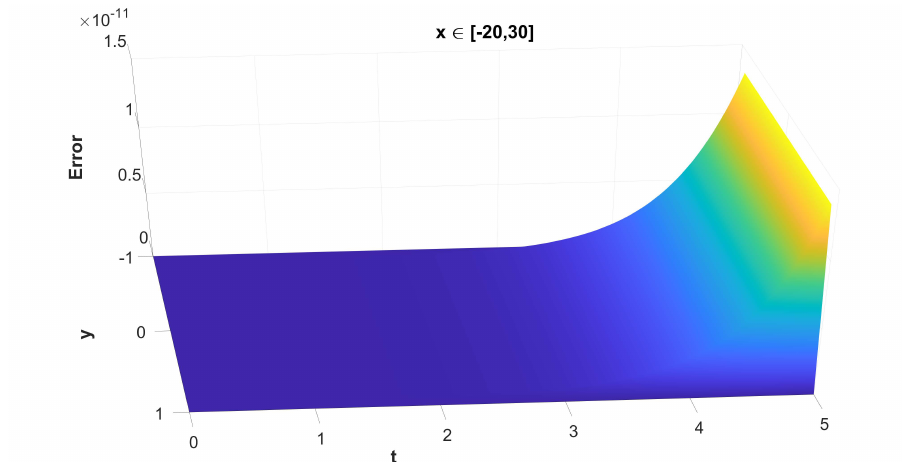
Figure 12. The maximum, along x , absolute error of the solution versus t and y without the use of finite difference schemes for the spatial